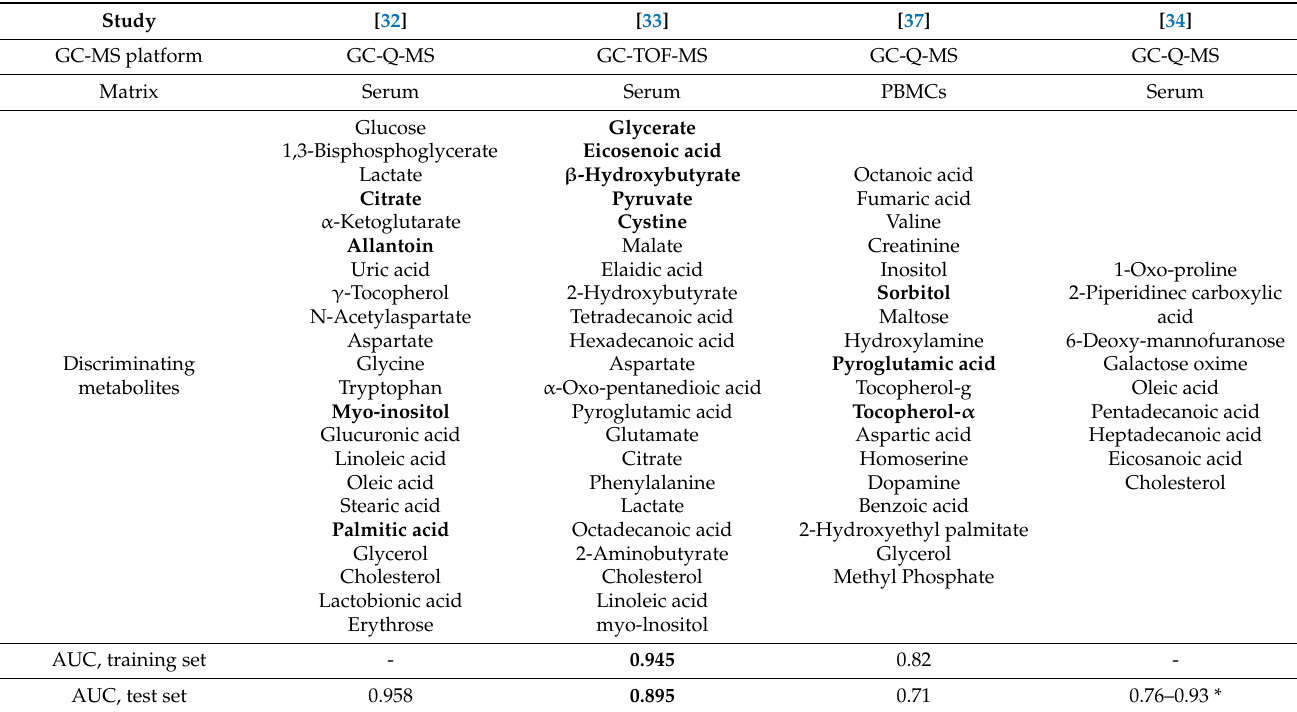
Table 7. Distinct metabolites between unmedicated schizophrenia patients and normal controls revealed by different metabolite profiling studies